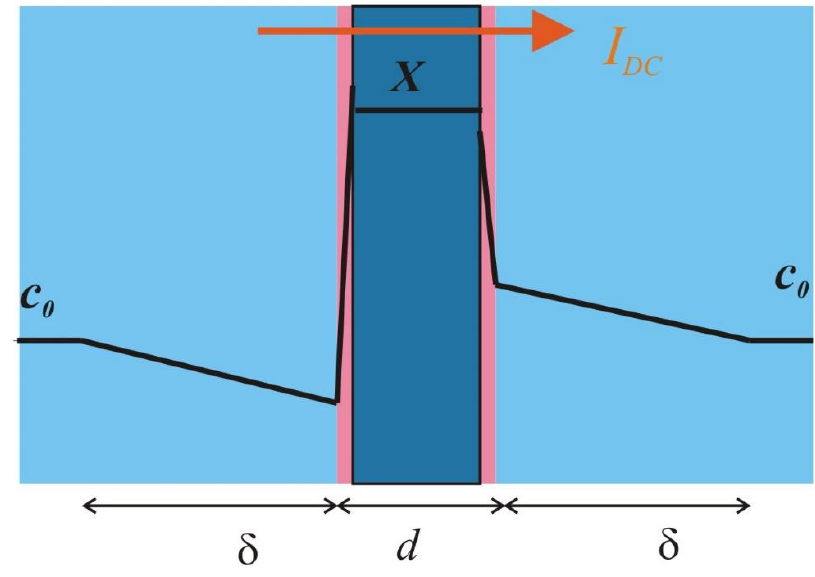
Figure 1. Sketch of the ion-exchange membrane system.